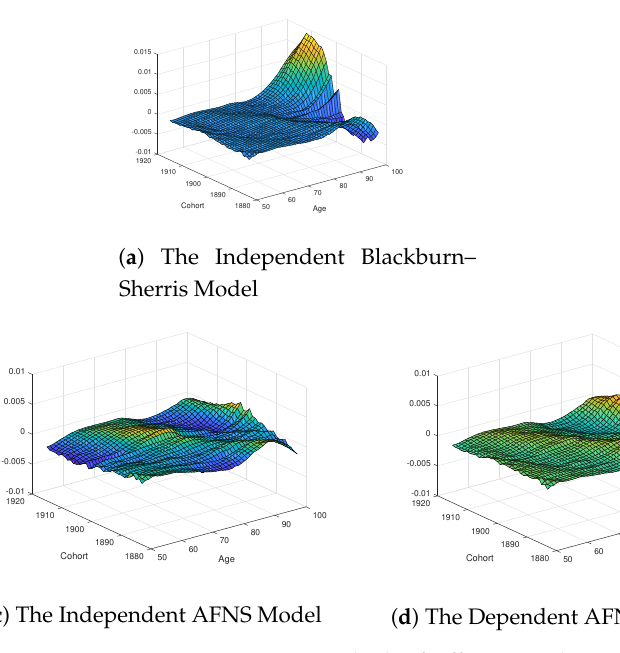
Figure 7. Residuals of Affine Mortality